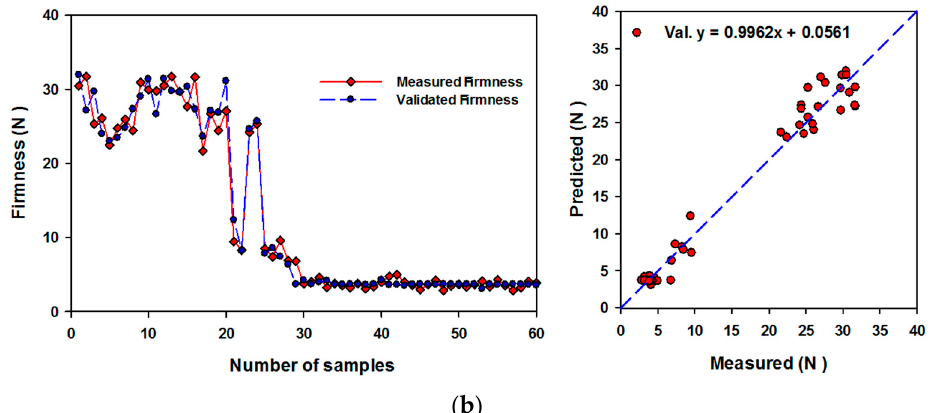
Figure 4. ( a ) Comparison between measuring datasets and validating datasets for Chl a, Chl b, and respiration rate (Rr) using the ANN models. Statistical analysis was shown in Table 6. ( b ) Comparison between measuring datasets and validating datasets for TSS and firmness using the ANN models. Statistical analysis is shown in Table 6. Table 6. Results of ANN calibration and validation models for the relationship between SRIs and Chl a, Chl b, respiration rate, TSS, and firmness of banana fruits.